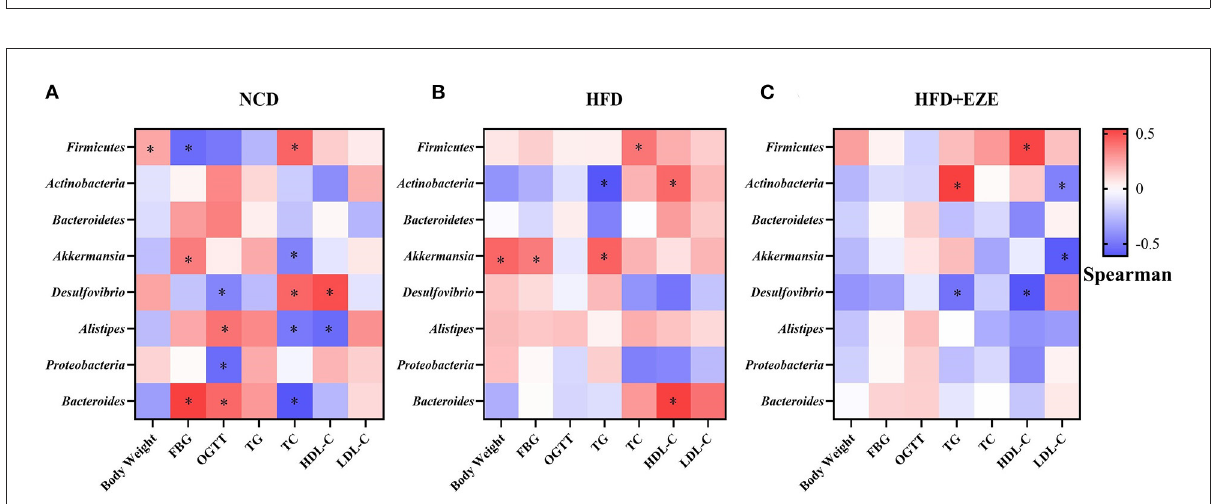
FIGURE8 Correlations between ezetimibe responsive core microbes and phenotypes. (A) Heatmap of the correlations between ezetimibe responsive core microbes and phenotypes in the NCD group. (B) Heatmap of the correlations between ezetimibe responsive core microbes and phenotypes in the HFD group. (C) Heatmap of the correlations between ezetimibe responsive core microbes and phenotypes in the HFD + EZE group. *Indicated that the correlations were statistically significant. Blue indicated the negative correlations, while red indicated the positive correlations. FBG, fasting blood glucose; OGTT, oral glucose tolerance test; TG, Triglyceride; TC, total cholesterol; LDL-C, low-density lipoprotein-cholesterol; HDL-C, high-density